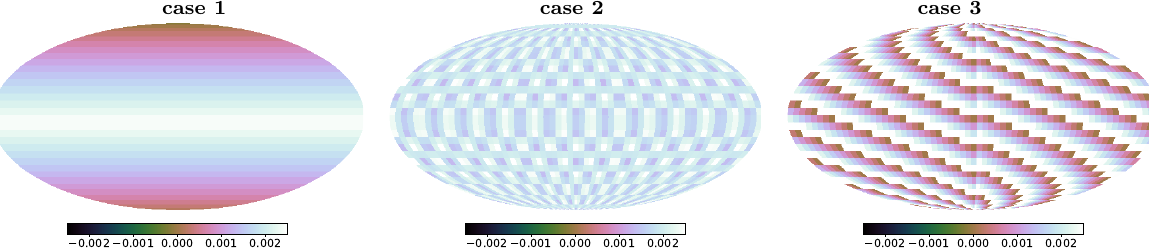
Fig. 1.— The real part of the multiplicative field m R ( Ω ) , in the three example cases investigated. Shown is a simulated celestial sphere in a Mollweide Projection with θ = φ = 0 at the North pole. The colour scale represents the amplitude of the biases. 2018), using the massmappy code (Wallis et al. 2017). In all cases we use SSHT McEwen et al. (2013) to compute